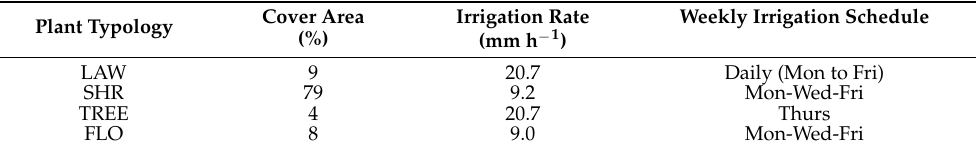
Table 1. Plantation